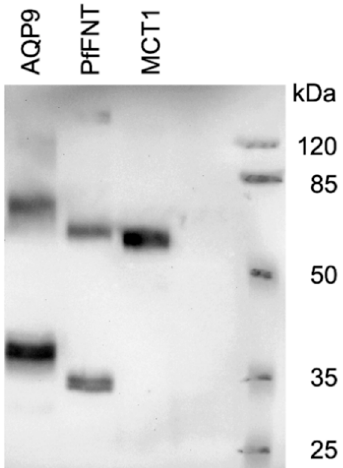
Figure 2. Western blot showing AQP9 (39 kDa monomer molecular weight), PfFNT (plasmodium falciparum FNT, 34 kDa monomer), and MCT1 (60 kDa) in falciparum FNT, 34 kDa monomer), and MCT1 (60 kDa) in yeast.